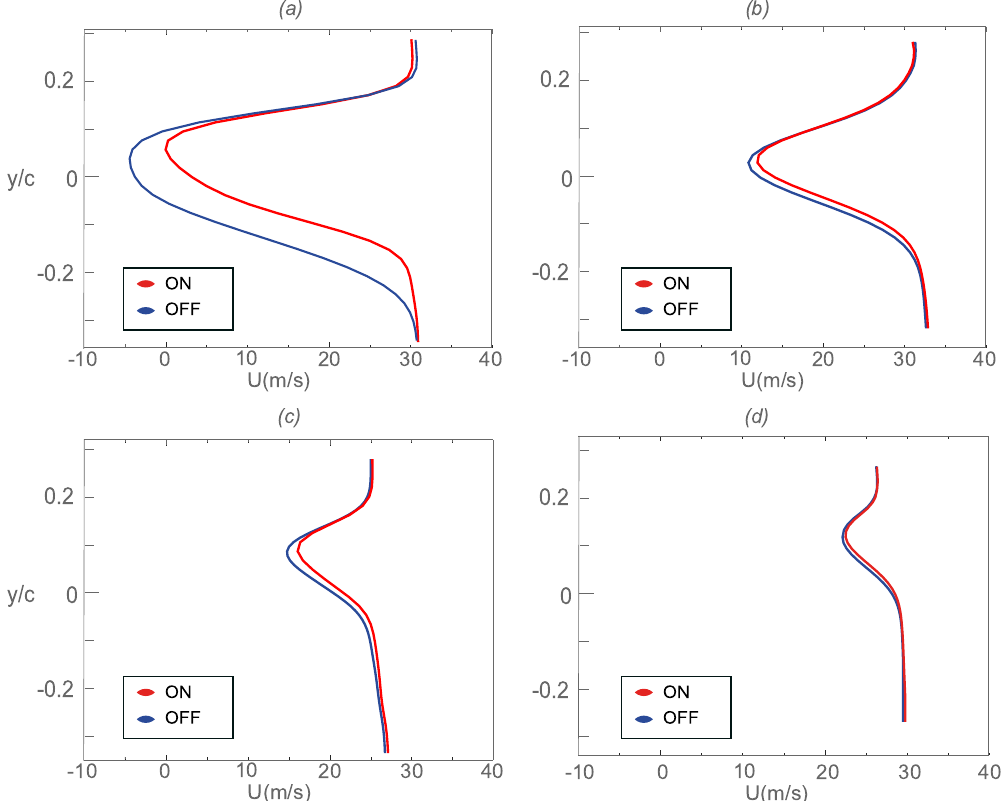
Figure 20. Cross-wake velocity profiles at ( a ) T A , ( b ) T B , ( c ) T C , and ( d ) T E for α = 14.5 ◦ and U ∞ = 30